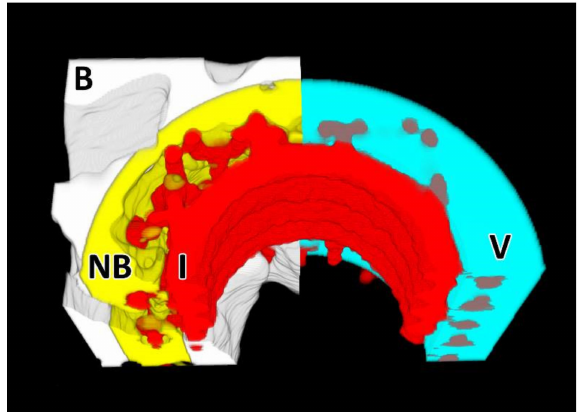
Figure 2. Definition of the micro-CT regions. The VOI (V) consisted of a hollow cylinder with an outer diameter with the same dimensions as the drilled defect and an inner diameter of that of the implant (I) wall. The bone tissue is denoted as B (white) and the “new bone” inside the VOI as NB